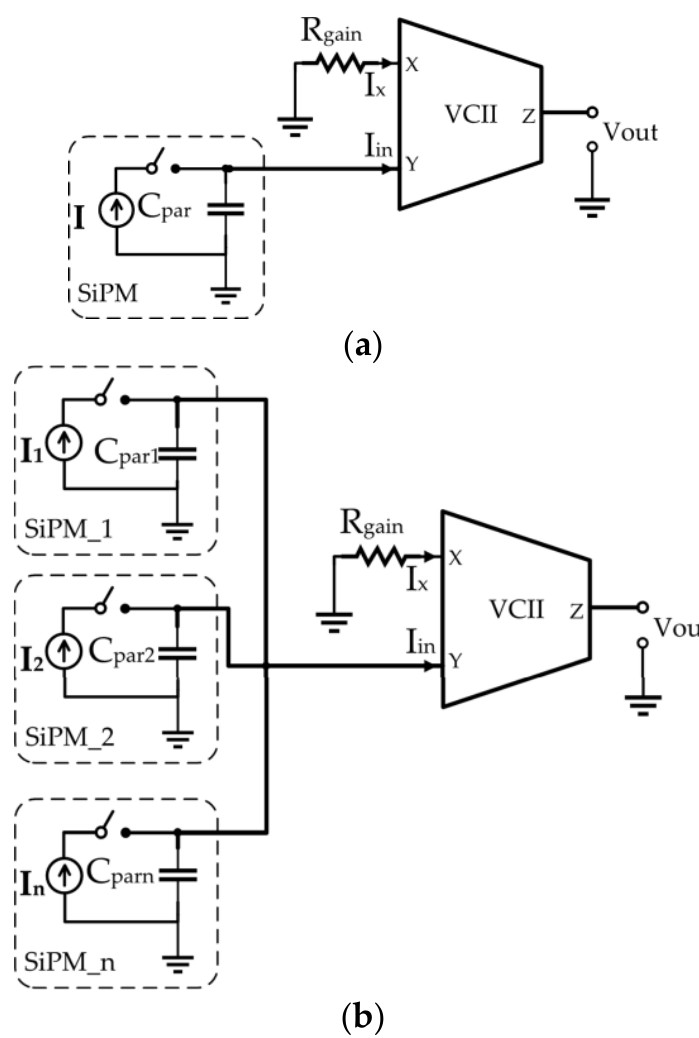
Figure 13. VCII-based interface circuits for ( a ) a single SiPM and ( b ) an array of SiPMs.